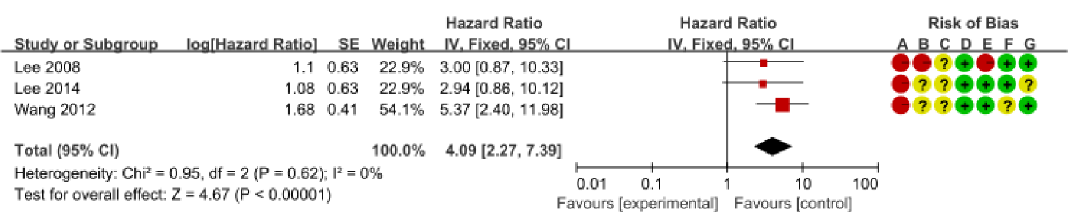
Fig 6. Forest plot of resection margin (-/+) and overall survival of small cell carcinoma of the cervix patients. SE: standard error; CI: confidence interval.